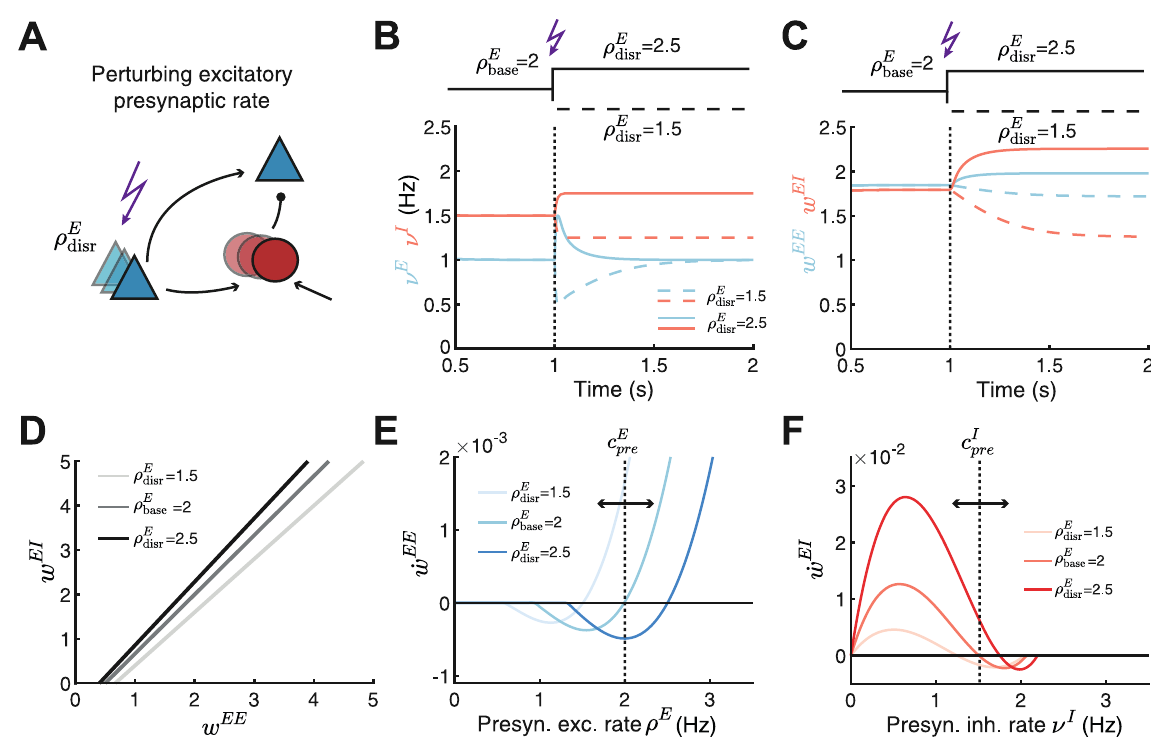
Fig 4. Nonlinear inhibitory plasticity can regulate the network response to perturbations. A . Schematic of perturbing the excitatory presynaptic rate in the inhibitory feedforward motif. We use the nonlinear inhibitory plasticity rule with identical excitatory and inhibitory LTD/LTP thresholds from Fig 2A. B . Effect of increasing (solid lines, r E ¼ 2 : 5 ) or decreasing (dashed lines, r E ¼ 1 : 5 ) excitatory input rates disr disr from a baseline of r E ¼ 2 on excitatory (blue) and inhibitory (red) firing rates. C . Same as B but for the w EE and w EI weights. D . The line base attractor for the baseline input r E and two input perturbations r E . E . E-to-E weight change _ w EE as a function of the presynaptic excitatory base disr rate ρ E for the baseline input r E and for two input perturbations r E . F . I-to-E weight change _ w EI as a function of the inhibitory rate ν I for the base disr and for two input perturbations r E baseline input r E base disr